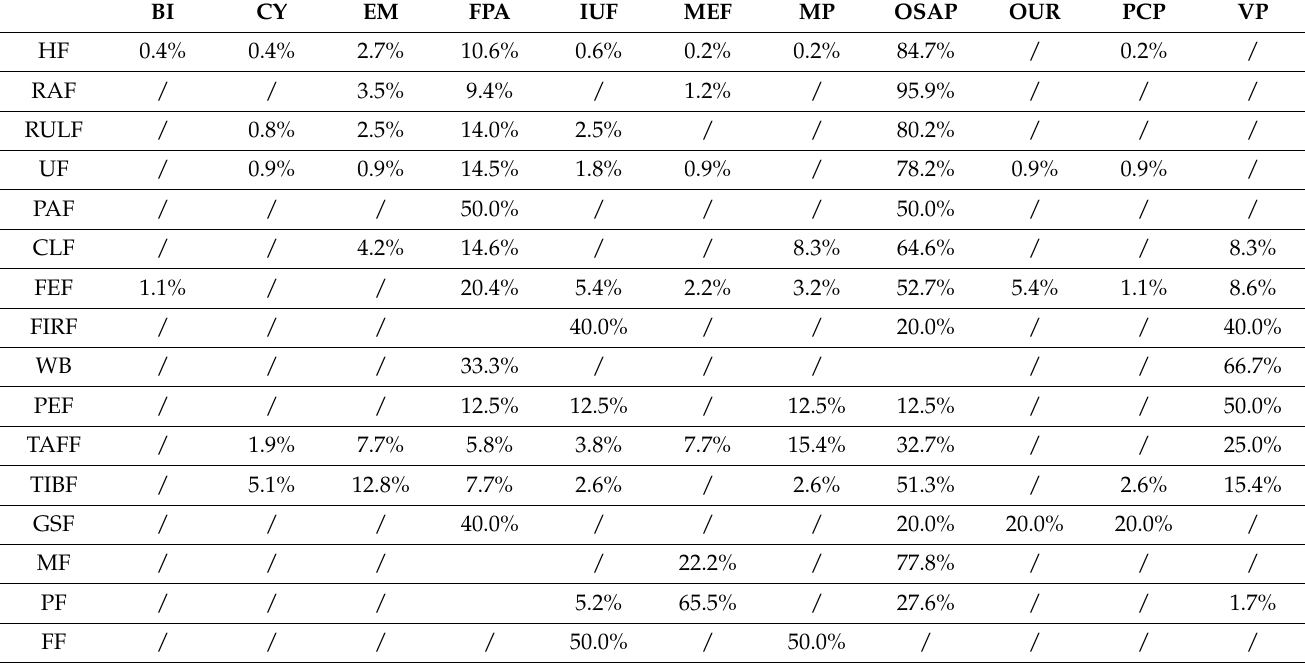
Table 2. The proportion of causes of injury in types of fractured